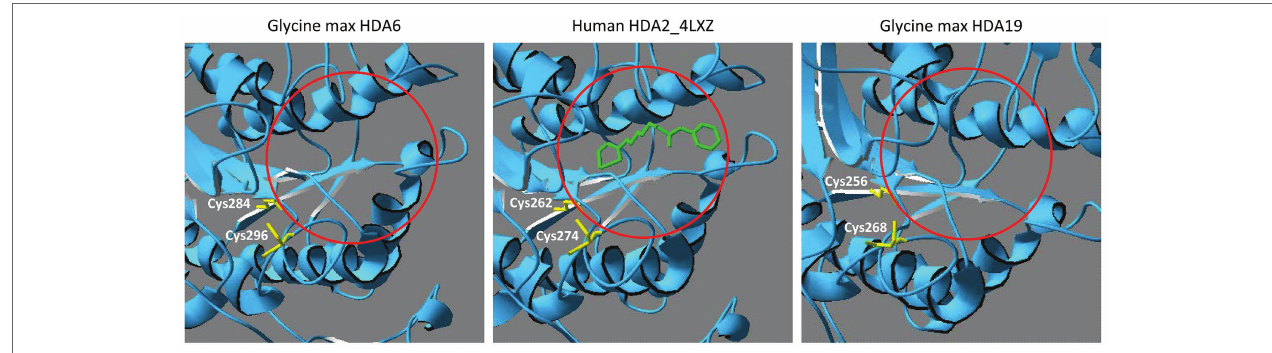
FIGURE 3 | Comparison of HDA6, HDA19 and human HDA2 substrate binding site. Structural comparison between human HDA2 and Glycine max HDA6 and HDA19. The HDA domains of G. max HDA6 (amino acids 29–397, Uniprot entry I1MTD8) and of G. max HDA19 (amino acids 3–371, Uniprot entry A0A0R0H2W2) were modeled using the SwissProt Modeling server with human HDA2 as template (PDB entry 4LXZ). The histone deacetylase inhibitor octanedioic acid hydroxyamide phenylamide is highlighted in green and shows the location of the active site (mark with a red circle). Cysteine residues, which are located next to the active site are marked in yellow. These cysteine residues are targets for S-nitrosation in human